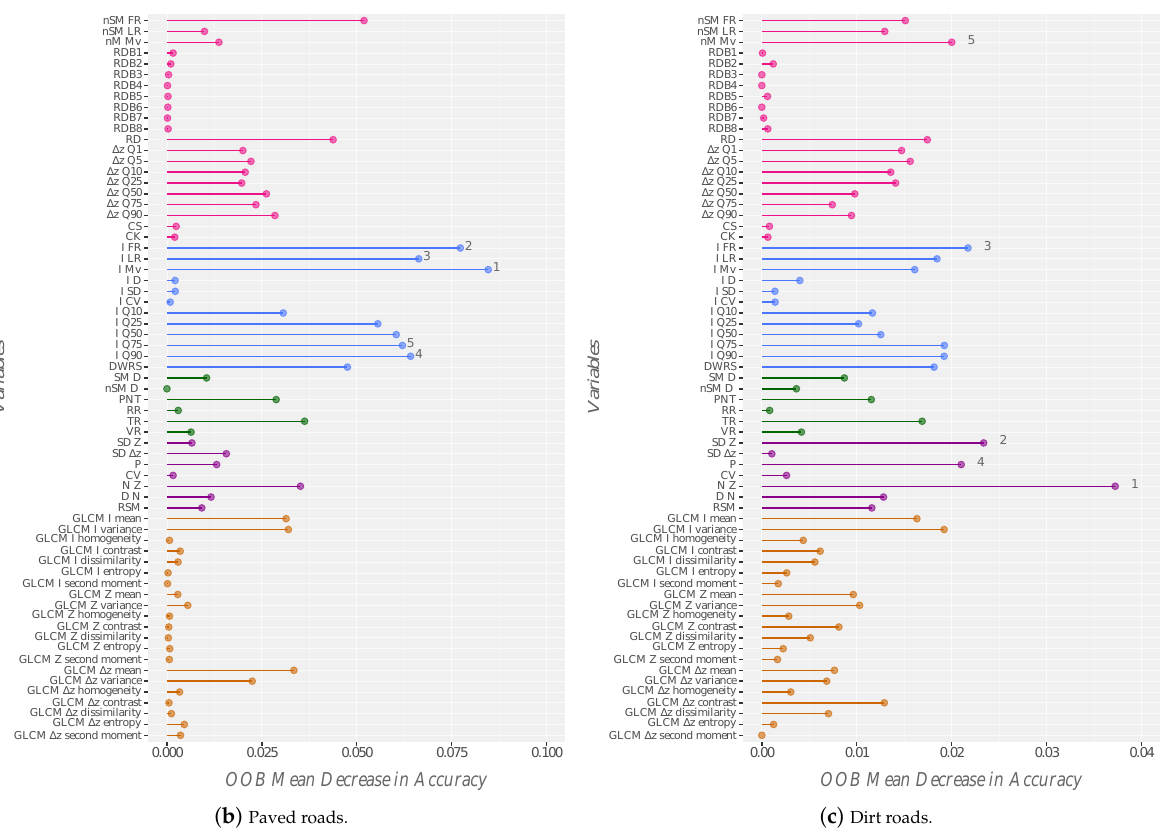
Figure 8. Importance of variables based on the categories determined using RF from original LiDAR point cloud. Eleva- tion/height variables are shown in magenta, intensity variables in blue, return variables in green, roughness variables in purple and texture variables in